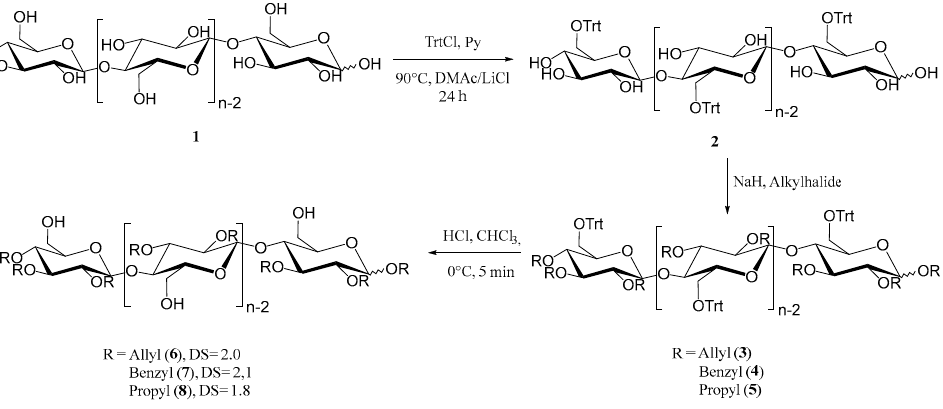
Figure 1. Synthesis of regioselectively substituted 2,3-di-O-alkyl cellulose derivatives as macroinitiators for the consecutive ring opening polymerization with ε -caprolactone.